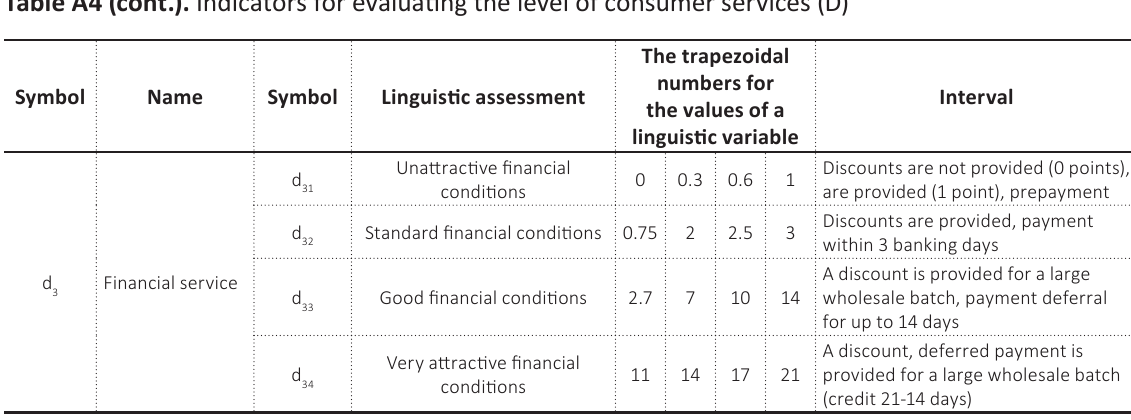
Table A6. Rules for forming an